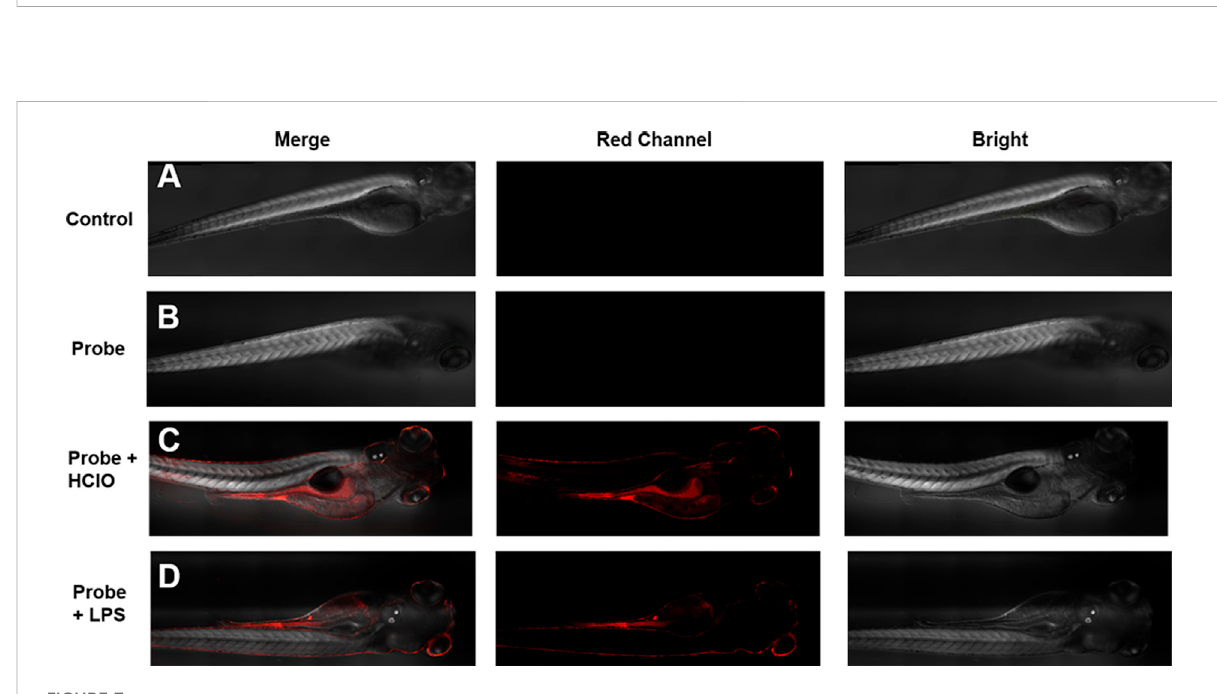
FIGURE 7 Imaging of HClO in zebra fi sh with the probe HDCX-HClO (10 μ M). (A) Zebra fi sh blank without dealing with the probe; (B) zebra fi sh was incubated with HDCX-HClO for 30 min before imaging; (C) zebra fi sh loaded with the probe HDCX-HClO and 30 μ M HClO; (D) zebra fi sh was stimulated with LPS/PMA and then stained by HDCX-HClO for 30 min before